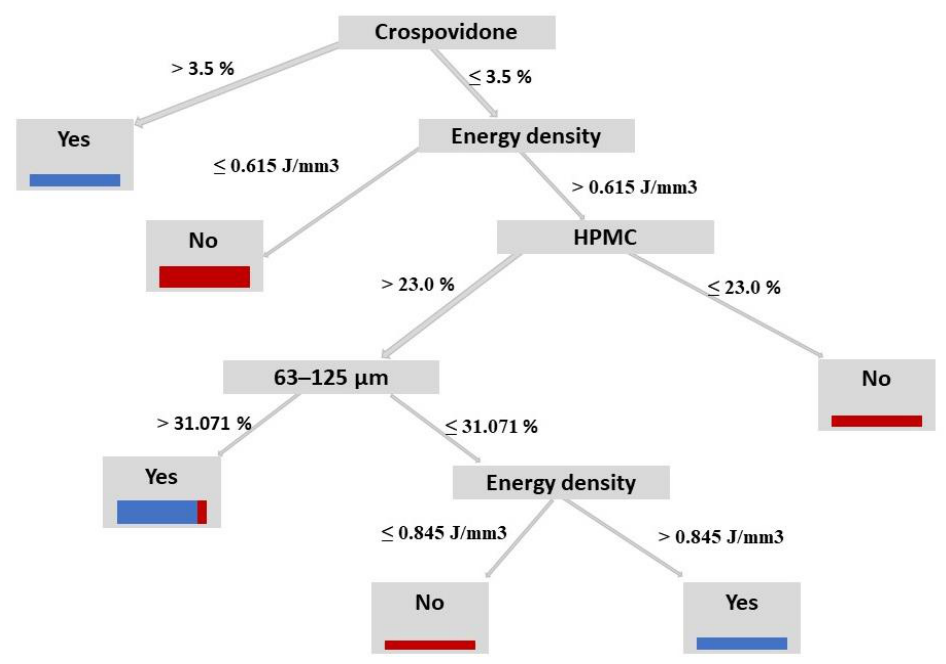
Figure 3. Decision tree for SLS printability of powder mixtures with irbesartan.